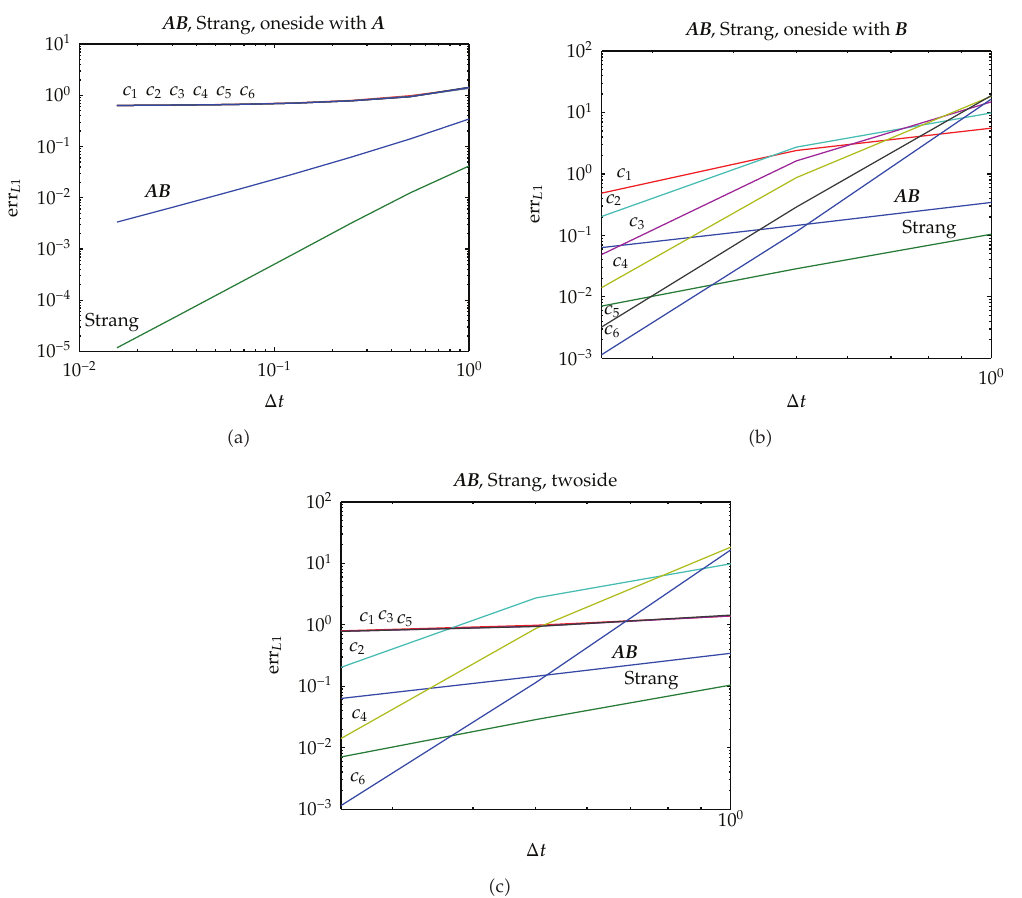
Figure 10: Numerical errors of the one-side splitting scheme with A (cid:5) a (cid:6) , the one-side splitting scheme with B (cid:5) b (cid:6) and the iterative schemes with 1 ,... , 6 iterative steps (cid:5) c (cid:6)